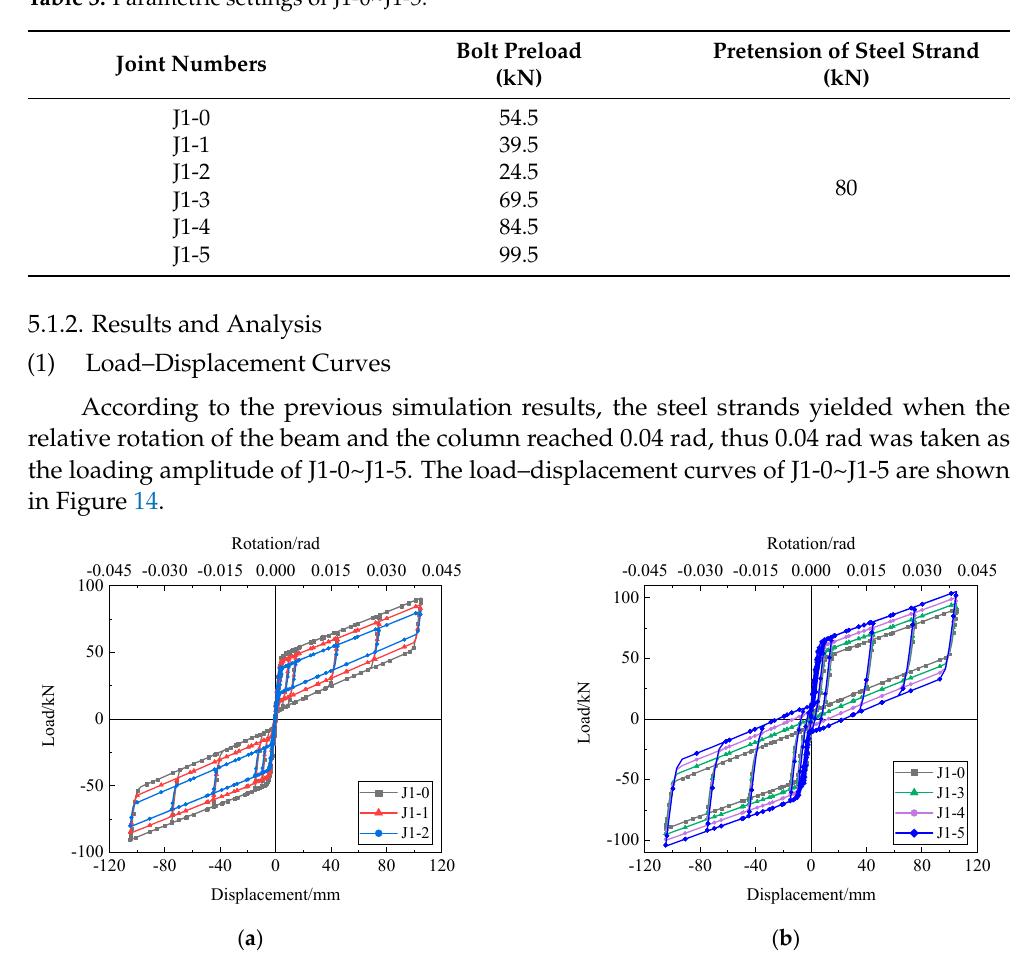
Table 3. Parametric settings of J1-0~J1-5.